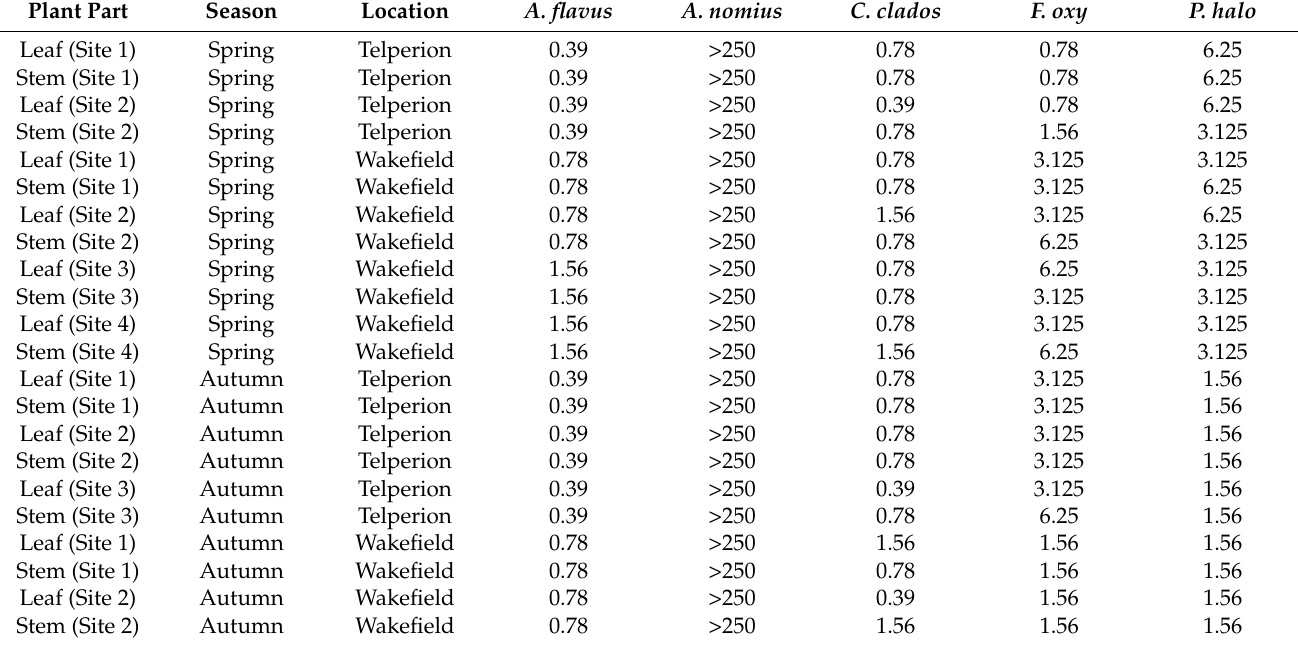
Table 2. The MIC values ( µ g/mL) for extracts from different parts of H. aureonitens specimens obtained from different sites at two different climatic locations and in two different seasons of cladosporioides ( C. clados ), Fusarium oxysporum ( F. oxy ) and Penicillium halotolerans ( P. halo